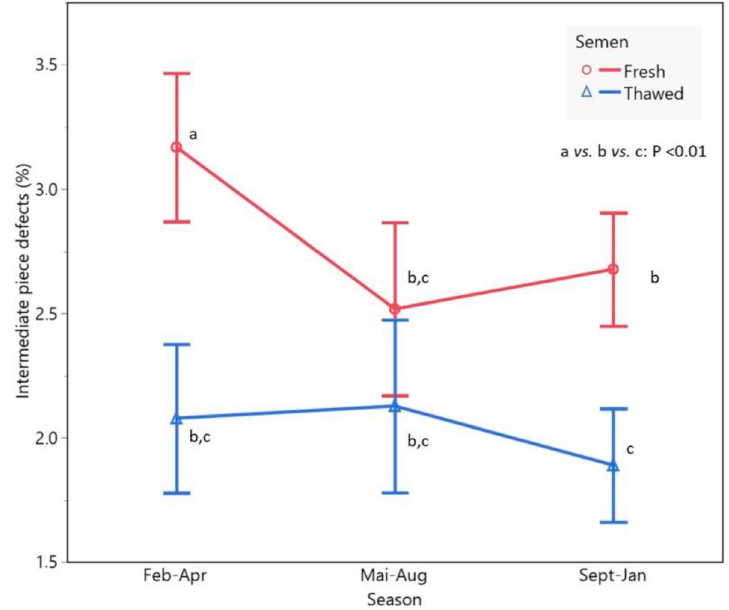
Figure 2. LSmean differences ( p < 0.01) of intermediate piece by the season and processing semen. The vertical bars represent the 95% confidence